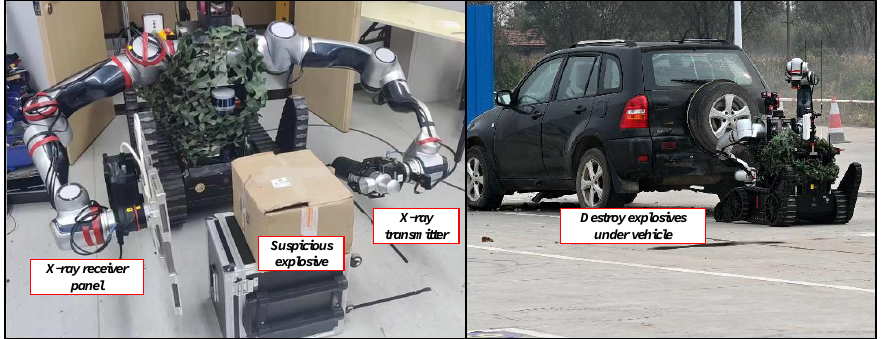
Figure 16. Simulated explosive ordnance disposal scenario experiment (see details in Supplemen- tary